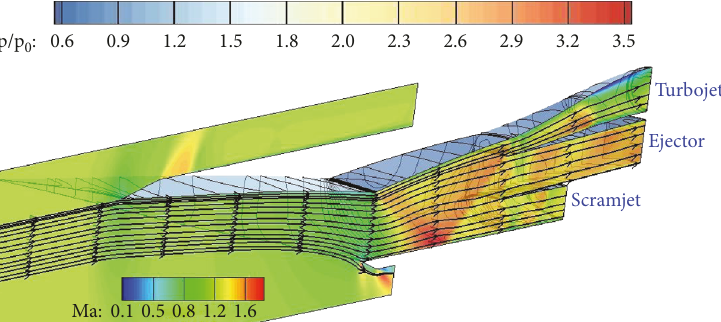
= 1 2 . The surface wall is contoured by the pressure ratio p/p ∞